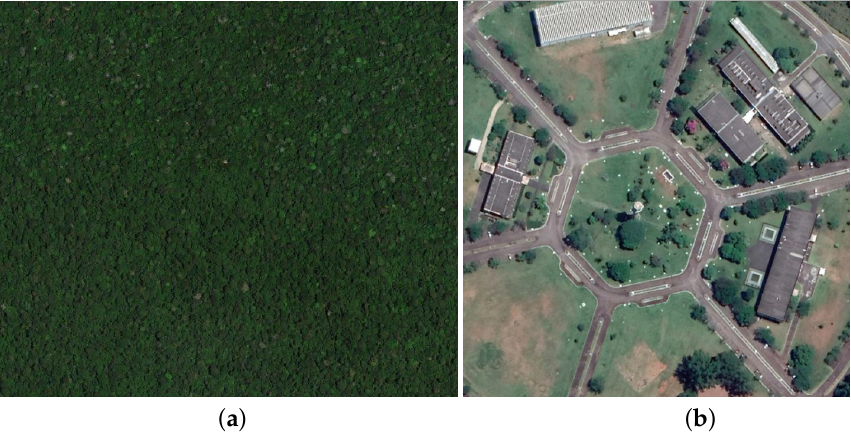
Figure 1. Two images of Brazil from a visible band camera: ( a ) over the Amazon region, ( b ) over a set of buildings in a urban